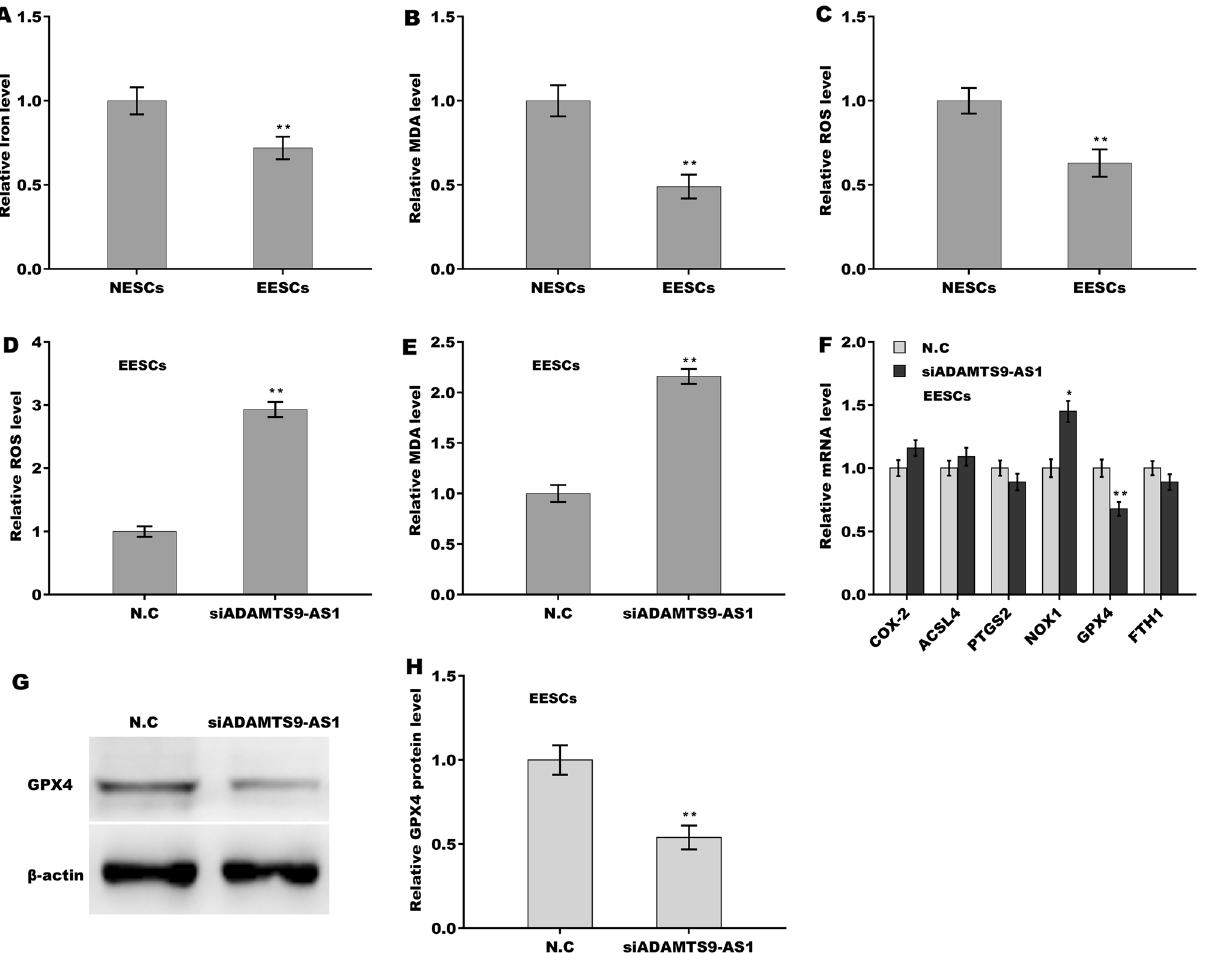
Figure 4. ADAMTS9-AS1 repressed ferroptosis of ESCs by regulating GPX4. The Fe 2+ levels ( A ), MDA content ( B ), and ROS levels ( C ) were assayed using the indicated kits for NESCs and EESCs. The ROS levels ( D ) and MDA content ( E ) were assessed using the indicated kits for EESCs after ADAMTS9-AS1 knockdown. ( F ) The mRNA levels of COX-2, ACSL4, PTGS2, NOX1, GPX4, and FTH1 were assayed using qPCR analysis in EESCs after ADAMTS9-AS1 knockdown. ( G , H ) The protein level of GPX4 was assayed using western blot analysis in EESCs after ADAMTS9-AS1 knockdown. * p < 0.05, ** p <